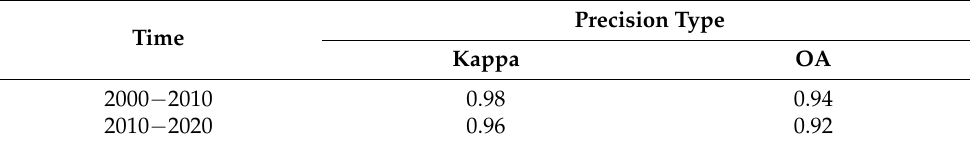
Table 4. Accuracy